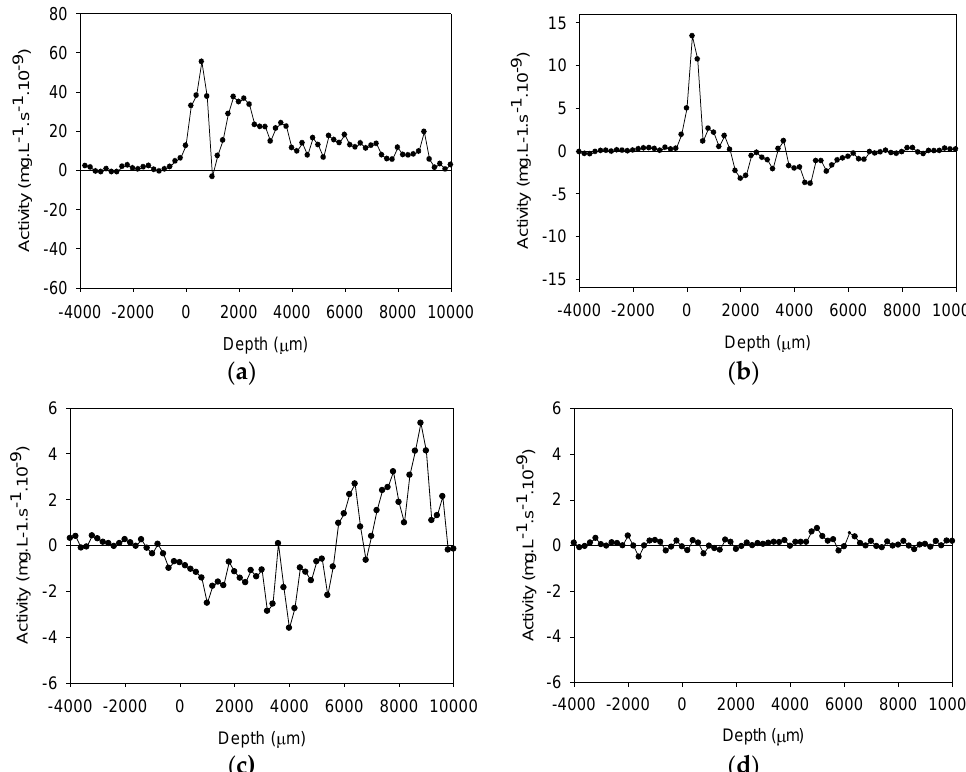
Figure 2. Activity profiles (a positive value represents consumption while a negative value represents production) of: ( a ) DO; ( b ) NH 4+ -N; ( c ) NO 3− -N; and ( d ) NO 2− -N.